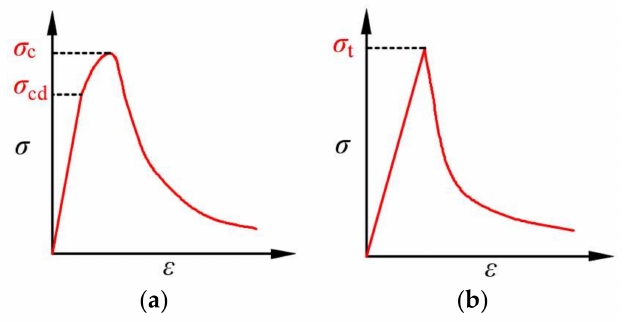
Figure 2. Diagrammatic sketch of uniaxial stress-strain curve from rock-like materials. ( a ) Compres- sion ( b ) tension.